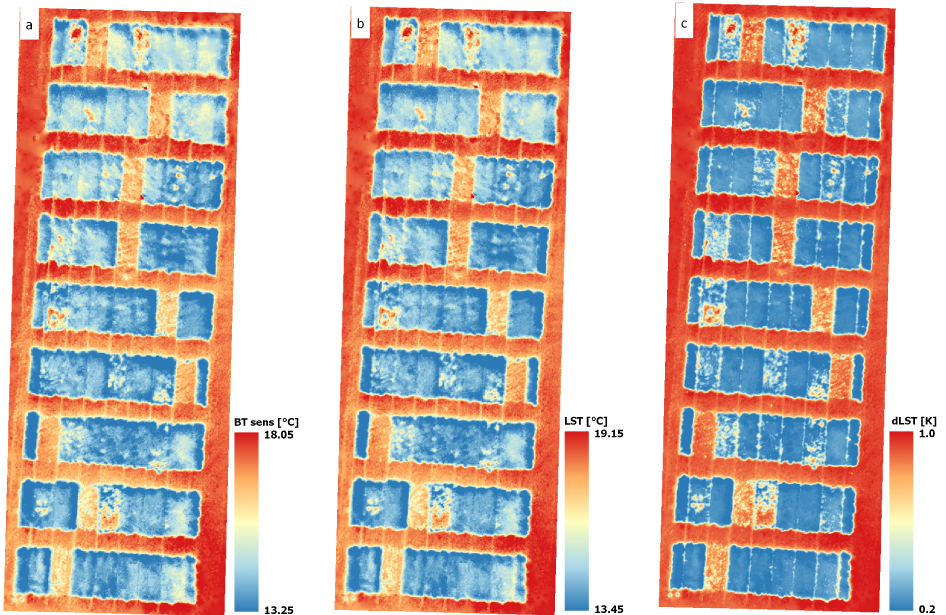
Figure 7. The temperature distribution between rape plots and surrounding soil areas: BT sens map ( a ) generated from the LWIR imagery (11 April 2018, 13:42 CET). The LST map ( b ) based on estimated LSE after the corrections were made. The dLST map ( c ) was computed to quantify the temperature deviation between BT sens and the retrieved